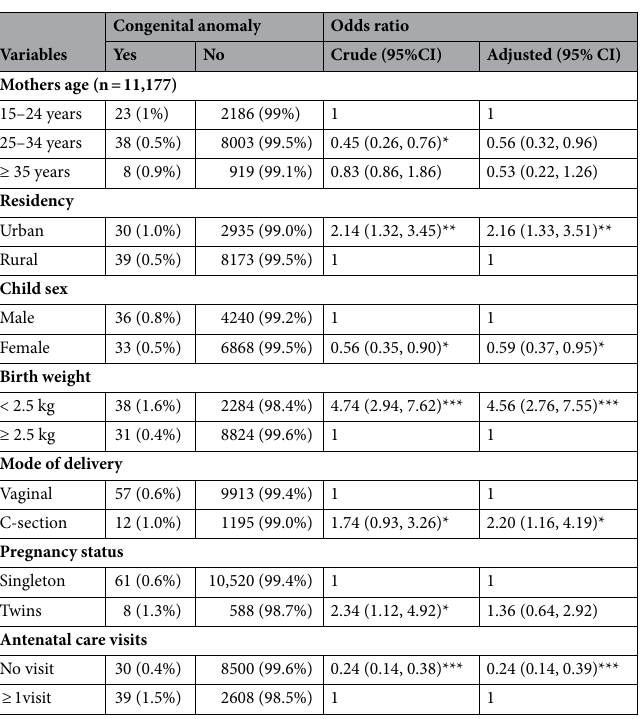
Table 5. Factors associated with congenital anomalies, Felege-Hiwot Comprehensive Specialized Referral Hospital, Bahir Dar, Sept. 2009 to Aug. 2014. Statistical significance at: *p-value < 0.05; **p-value < 0.01; ***p-value <